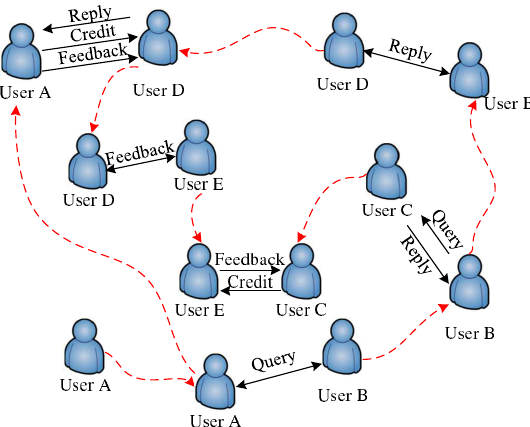
Figure 1. An example of data query and feedback in a small community where the red dotted curved arrow indicates the movement of a user, and the black solid straight line arrow depicts